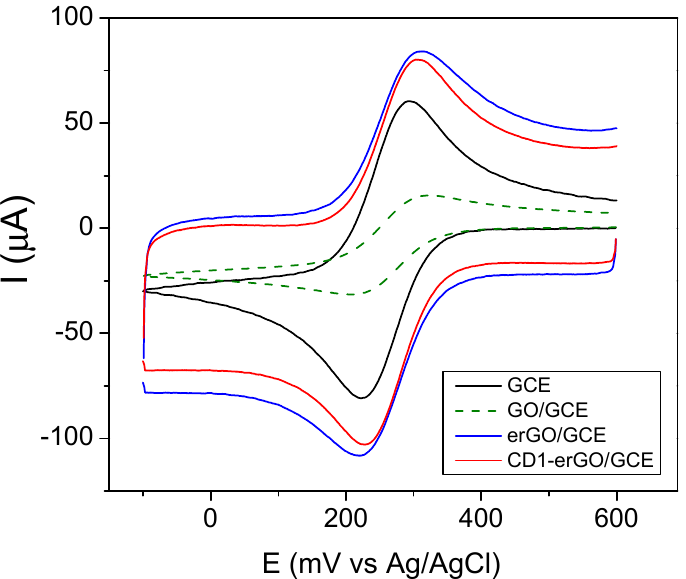
Figure 6. Cyclic voltammograms obtained in 5.0 mM K 3 [Fe(CN) 6 ] in 0.5 M KCl on bare GCE (black line), GO/GCE (dashed green line), erGO/GCE (blue line), and CD1-erGO/GCE (red line). Scan rate: 0.1 V s − 1 .